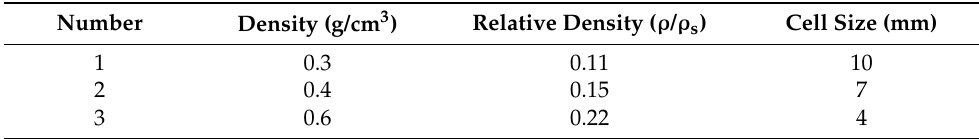
Table 1. Specification of core aluminum